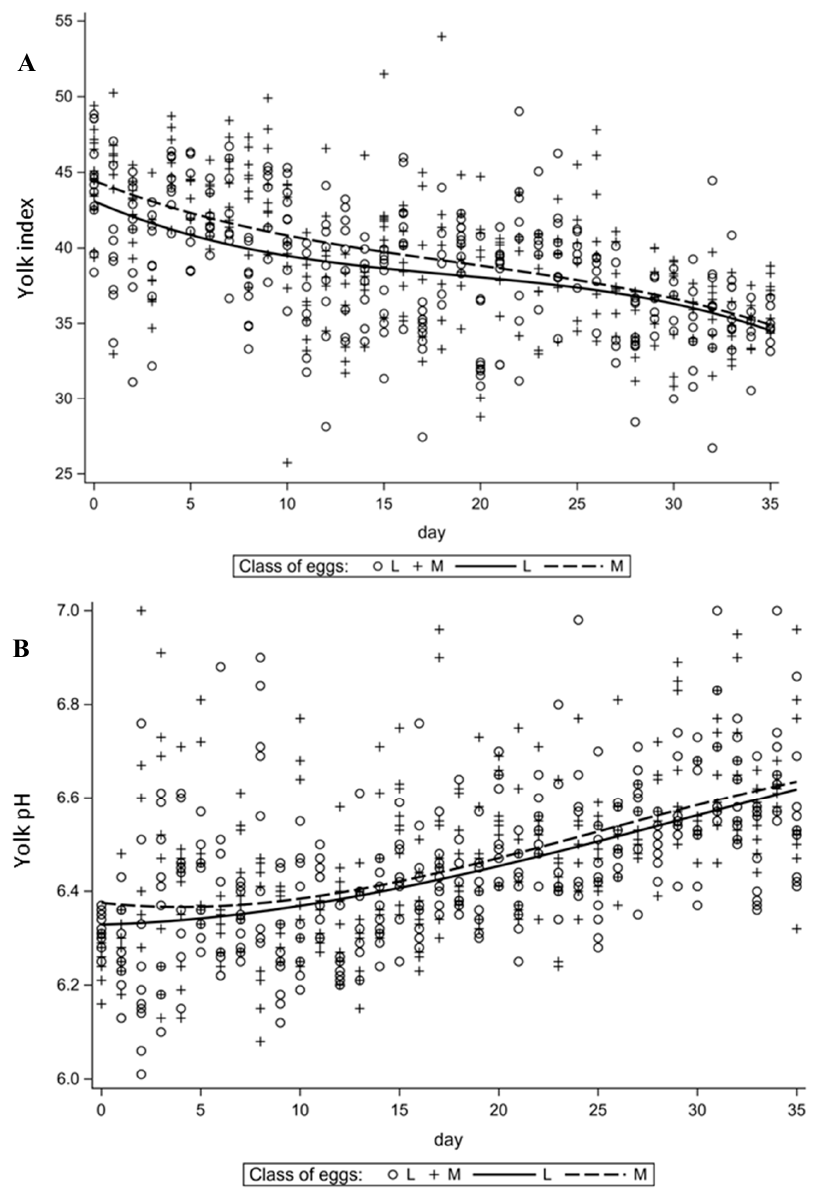
Figure 3. Changes in time of selected traits of egg yolk. ( A )—yolk index (YI), ( B )—yolk pH (YpH). Each of the models used, regardless of the trait analyzed, was characterized by high significance (Table 2). The fit of the data to the model (R 2 ) ranged from 0.1 for albumen weight in L class eggs to 0.71 for ApH of eggs of the same weight class. High R 2 values were also found for traits such as SG and ACD, regardless of the weight class of the eggs analyzed. The lowest values of the R 2 coefficient related to egg weight (0.17 and 0.2 for M and L grade eggs, respectively) and albumen weight (0.11 and 0.1 for M and L grade eggs, respectively). Student’s t ‐ tests comparing observed and predicted variables based on regression equations show no significant differences, confirming good model fitting.